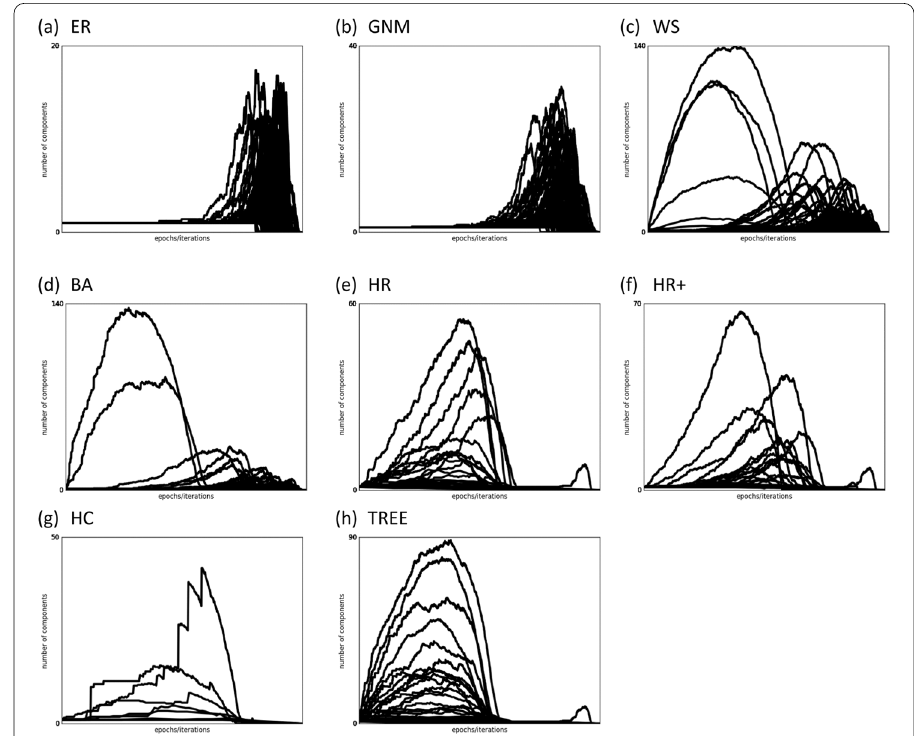
Fig. 6 The response of the eight graph models to the random node selection failure model method. Each response is plotted with the y-axis showing the number of components and the x-axis showing the % of nodes removed from the graph, and thus the most robust graphs would show a small number of components, with any increase shown to the right of plots as x tends away from 0. Plots ( a )–(d) show clear increase in the number of components to the right of the plots suggesting a robust response, whereas plots ( e )–( h ) show peaks much closer to the left and centre of the plots, suggesting a less robust